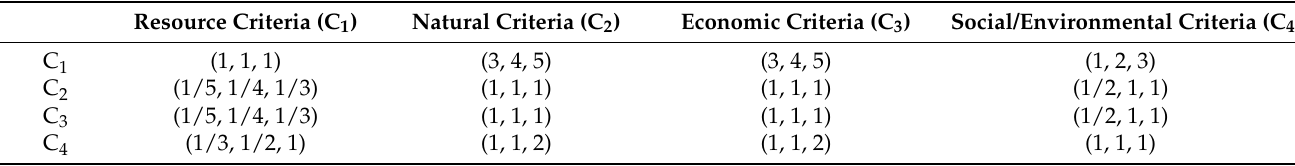
Table A4. Fuzzy pairwise comparison matrix of expert 4 (Weight: